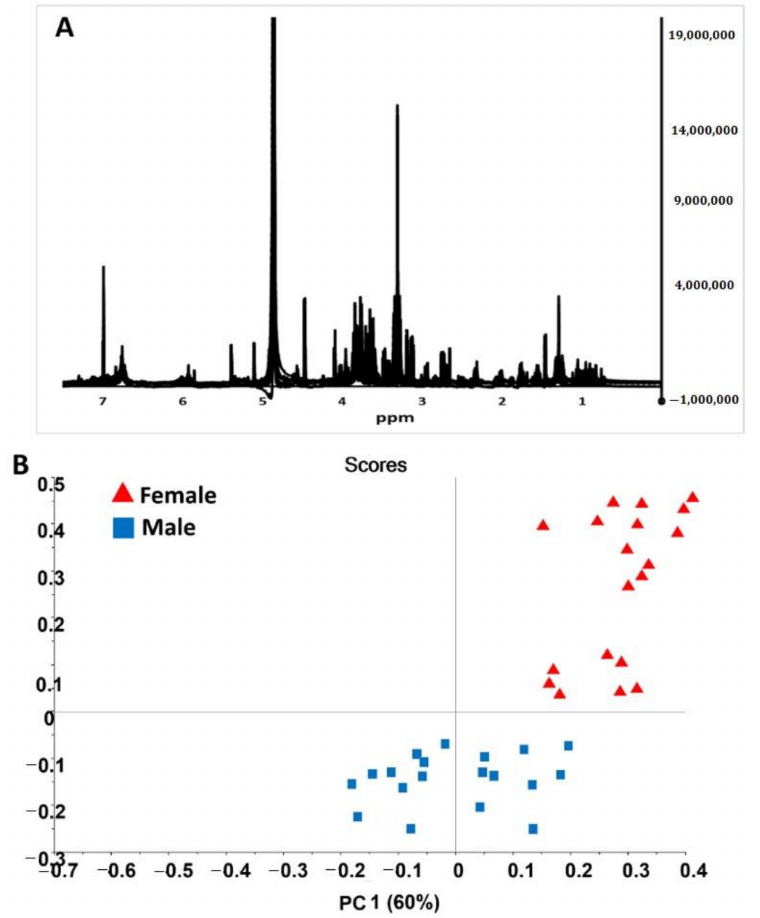
Figure 5. NMR spectral data analysis ( A ) NMR spectra of male and female date palm leaf extract samples from 20 male and 20 female samples. ( B ) PCA score plot of NMR spectral data of male and female date palm leaf extract